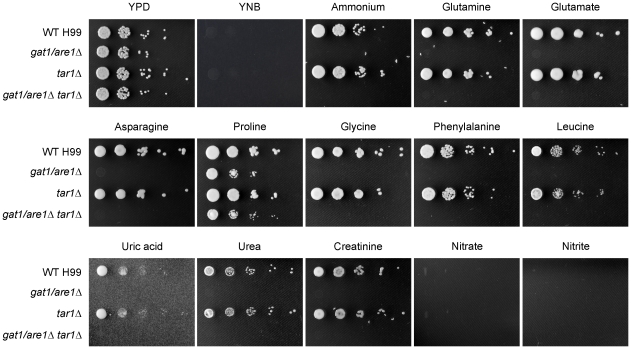
Tar1 is not required for nitrogen source utilization.Tenfold spot dilution assays for nitrogen utilization showed that the tar1Δ mutant exhibited wild-type growth on YNB supplemented with ammonium, glutamine, glutamate, asparagine, proline, glycine, phenylalanine, leucine, uric acid, urea and creatinine (10 mM each nitrogen source). In contrast, both the gat1/are1Δ and double gat1/are1Δ tar1Δ mutants were only able to proliferate on proline as the sole nitrogen source. All tested strains were unable to grow on 7% potassium nitrate or sodium nitrite.